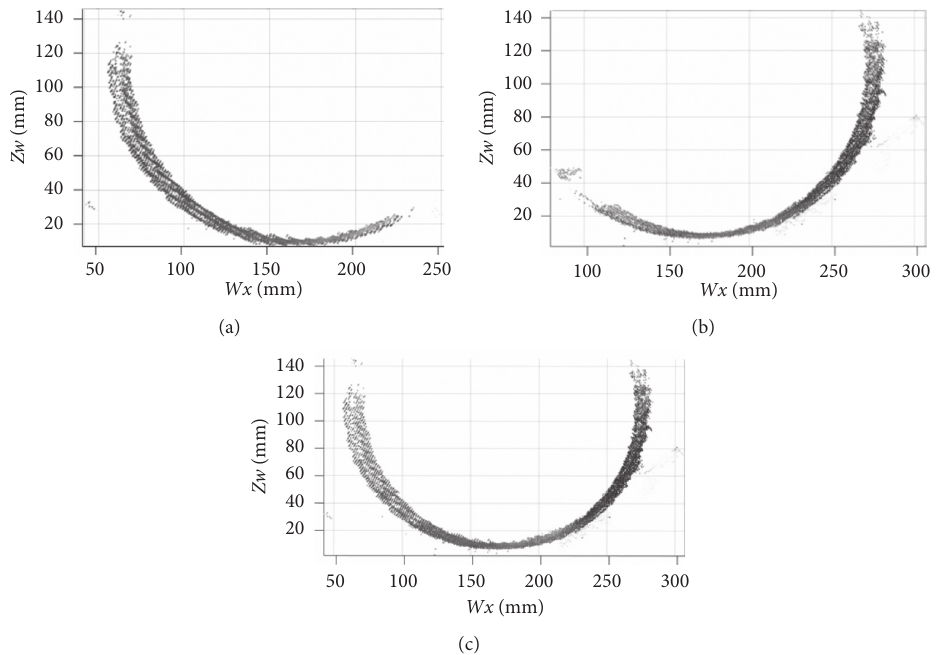
Figure 10: Top views of stitched point cloud: (a) point cloud acquired from CCS-A; (b) point cloud acquired from CCS-B; (c) stitched point cloud in WCS.